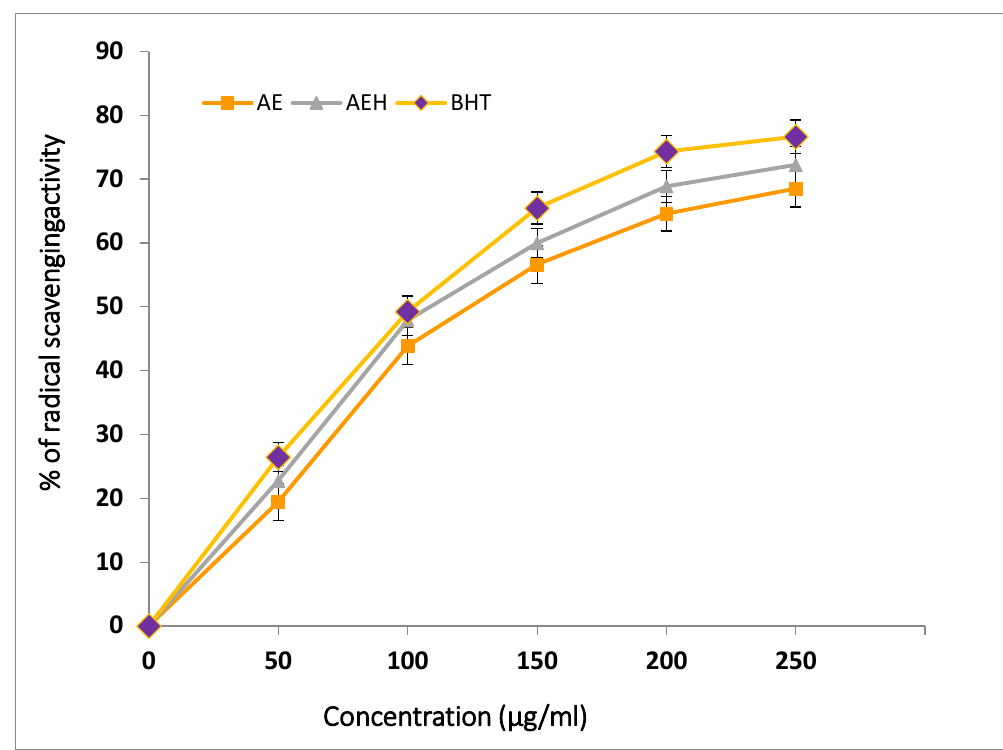
Figure 1. DPPH radical scavenging activity of MF extracts. AE = Aqueous extract; AEH = Aqueous ethanolic extract; BHT = Butylated hydroxytoluene